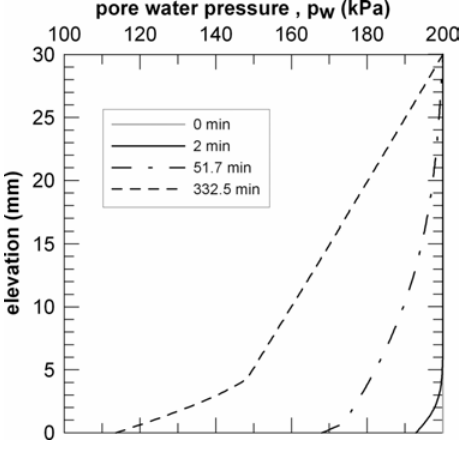
Fig. 16 – Electrokinetic consolidation test: isochrones of water pressure for gas production at the anode η . with = 0